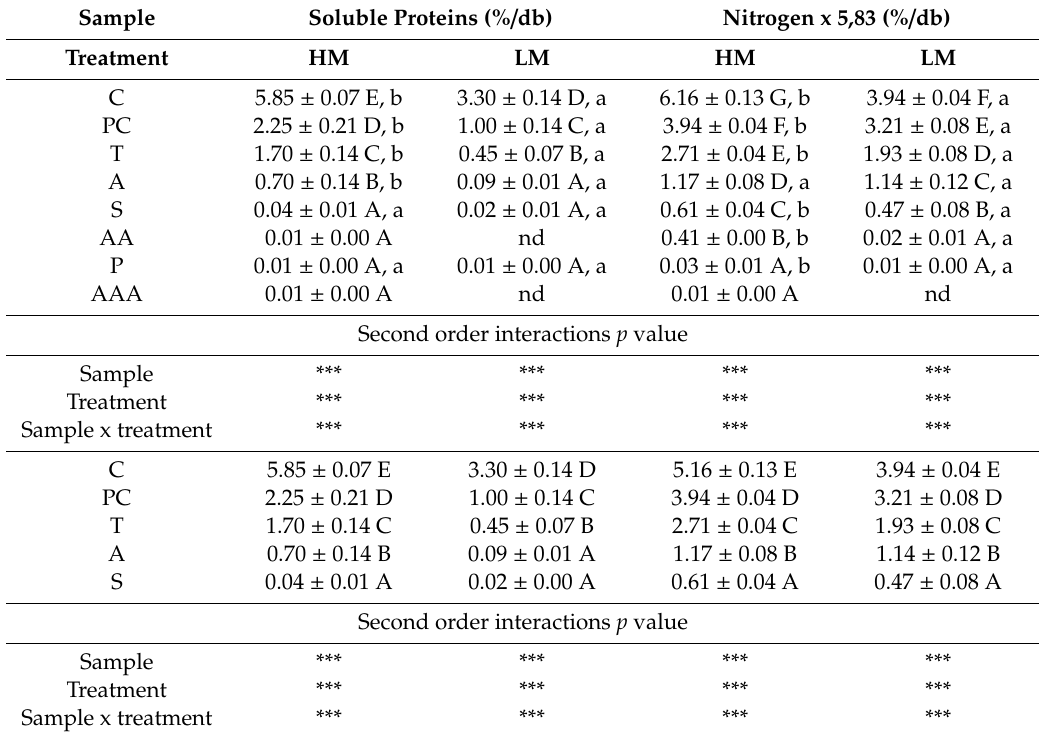
Table 2. Proteinaceous residuals content in obtained beta-glucan